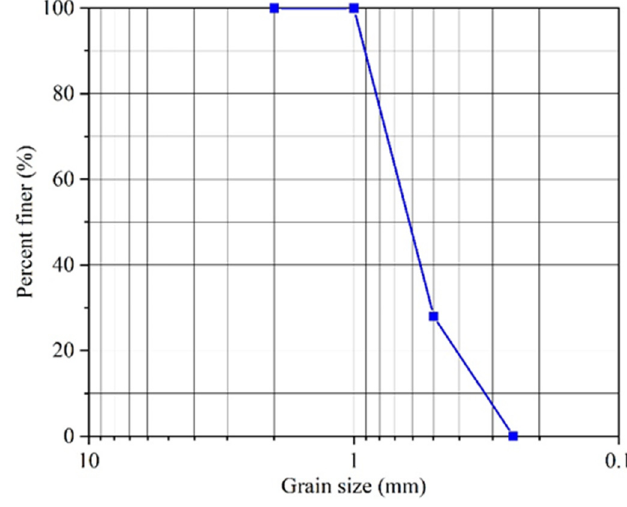
Figure 3. The grain size curve of the material. Table 2. Key parameters of dry sand.